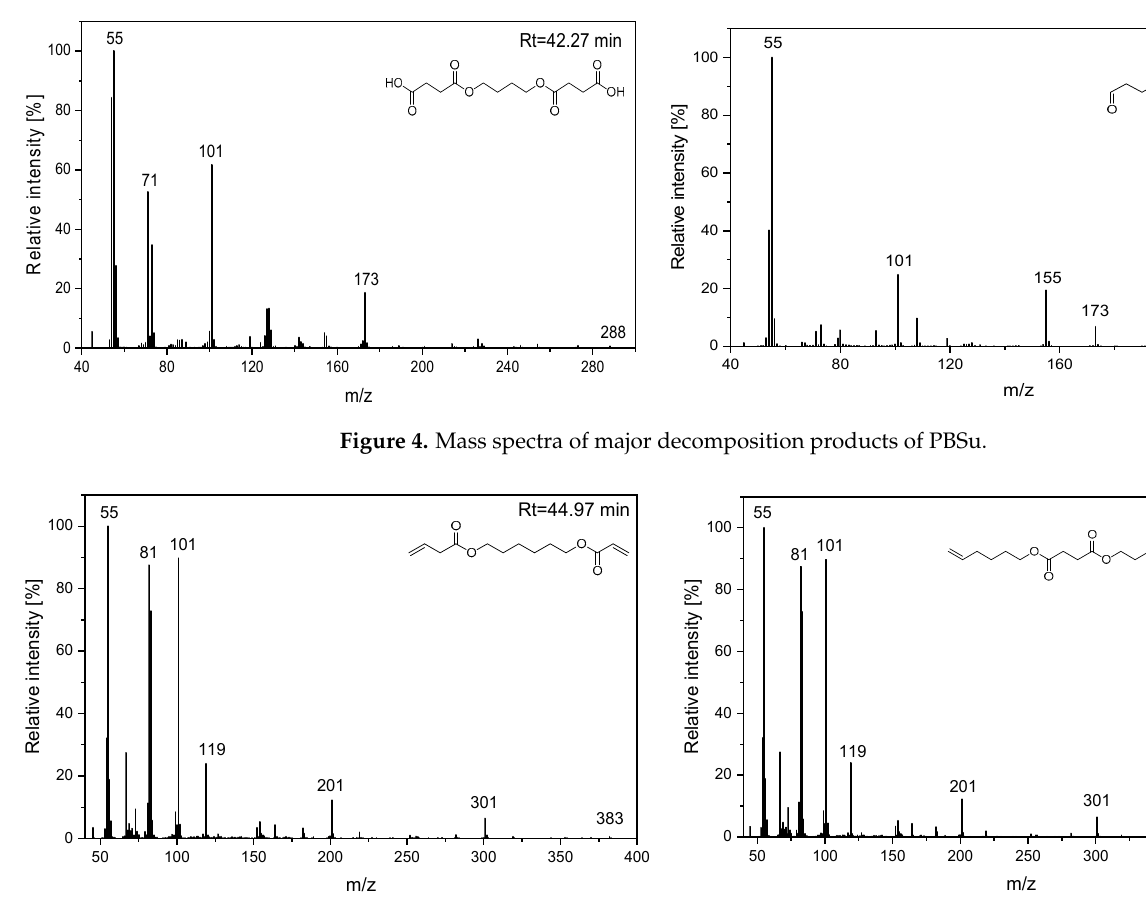
Figure 5. Mass spectra of the major decomposition products of PHSu. Table 6. Thermal decomposition products of POSu.